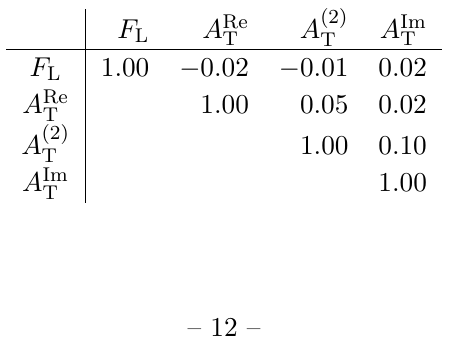
the SL/C background are obtained by tightening either the q 2 or BDT requirements used in the B 0 → K ∗ 0 e + µ −